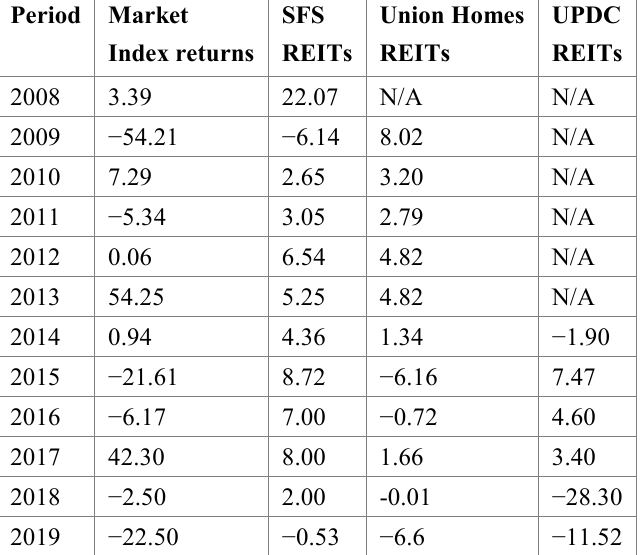
Table 2. Market Return Index and Total Returns for Selected Real Estate